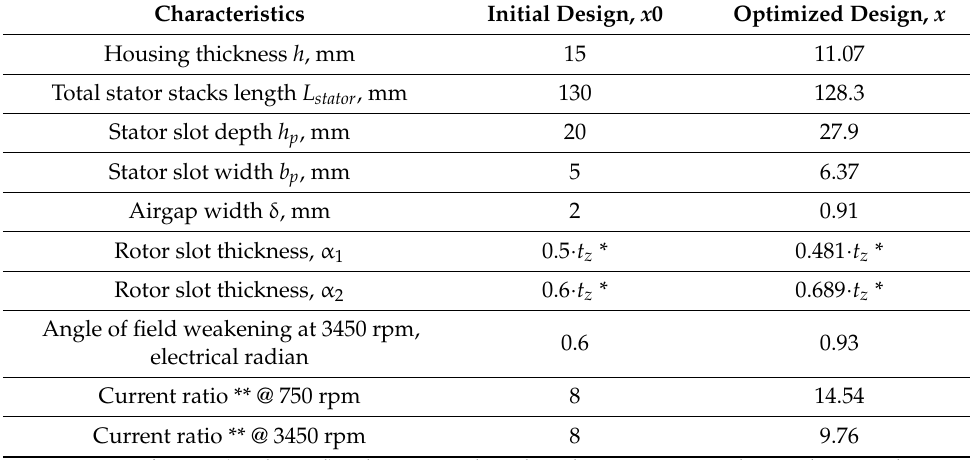
Table 2. Initial and optimized vectors of the variable optimization parameters.